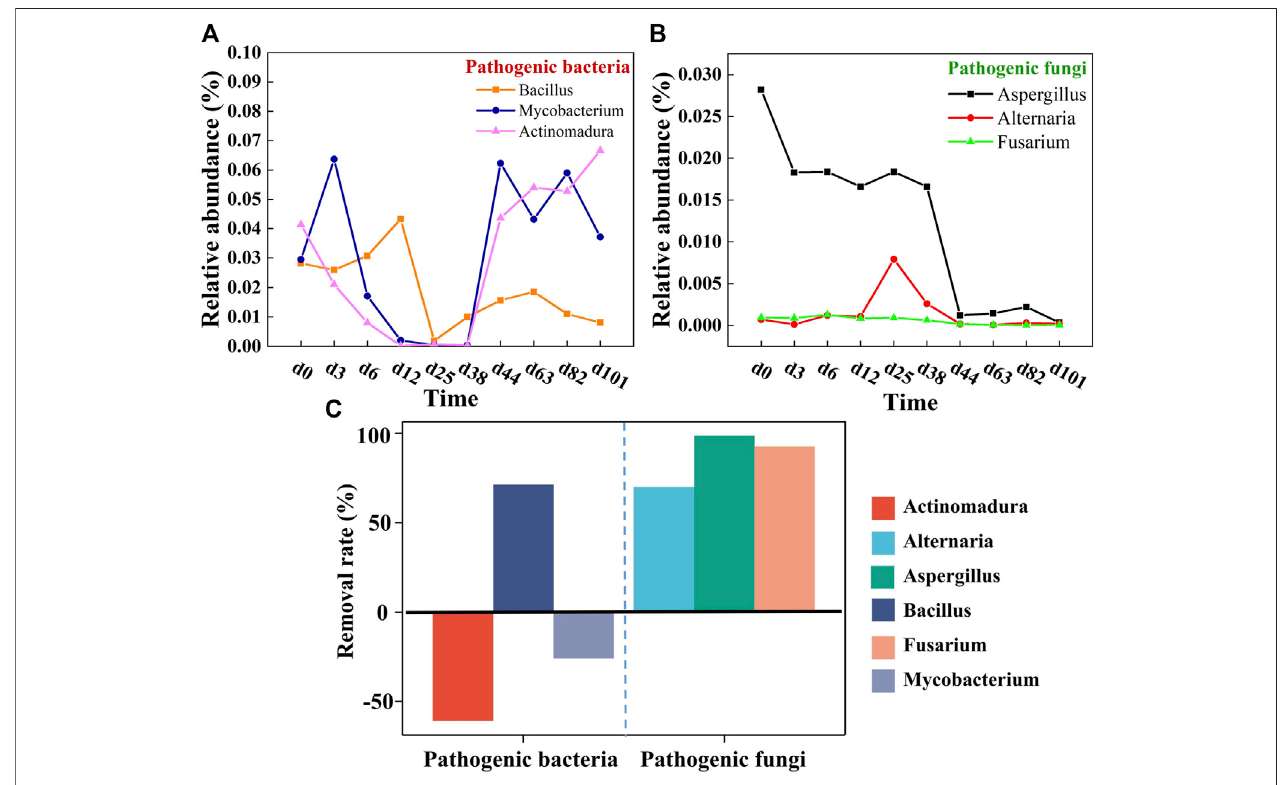
FIGURE 5 | Relative abundance of (A) pathogenic bacteria and (B) pathogenic fungi in top 20 genus and (C) their removal rates.